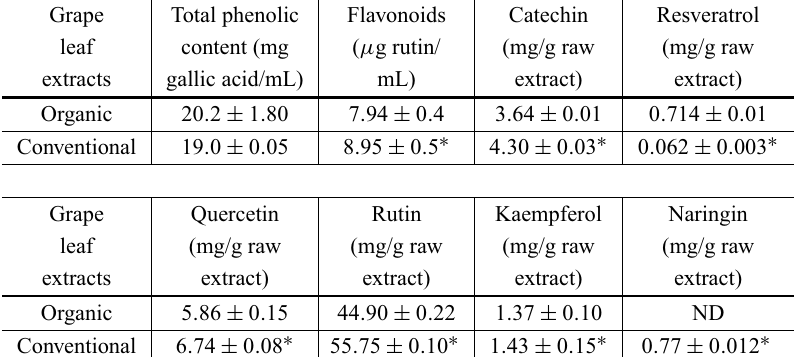
Phenolic content of organic and conventional grape leaf extracts 1 .